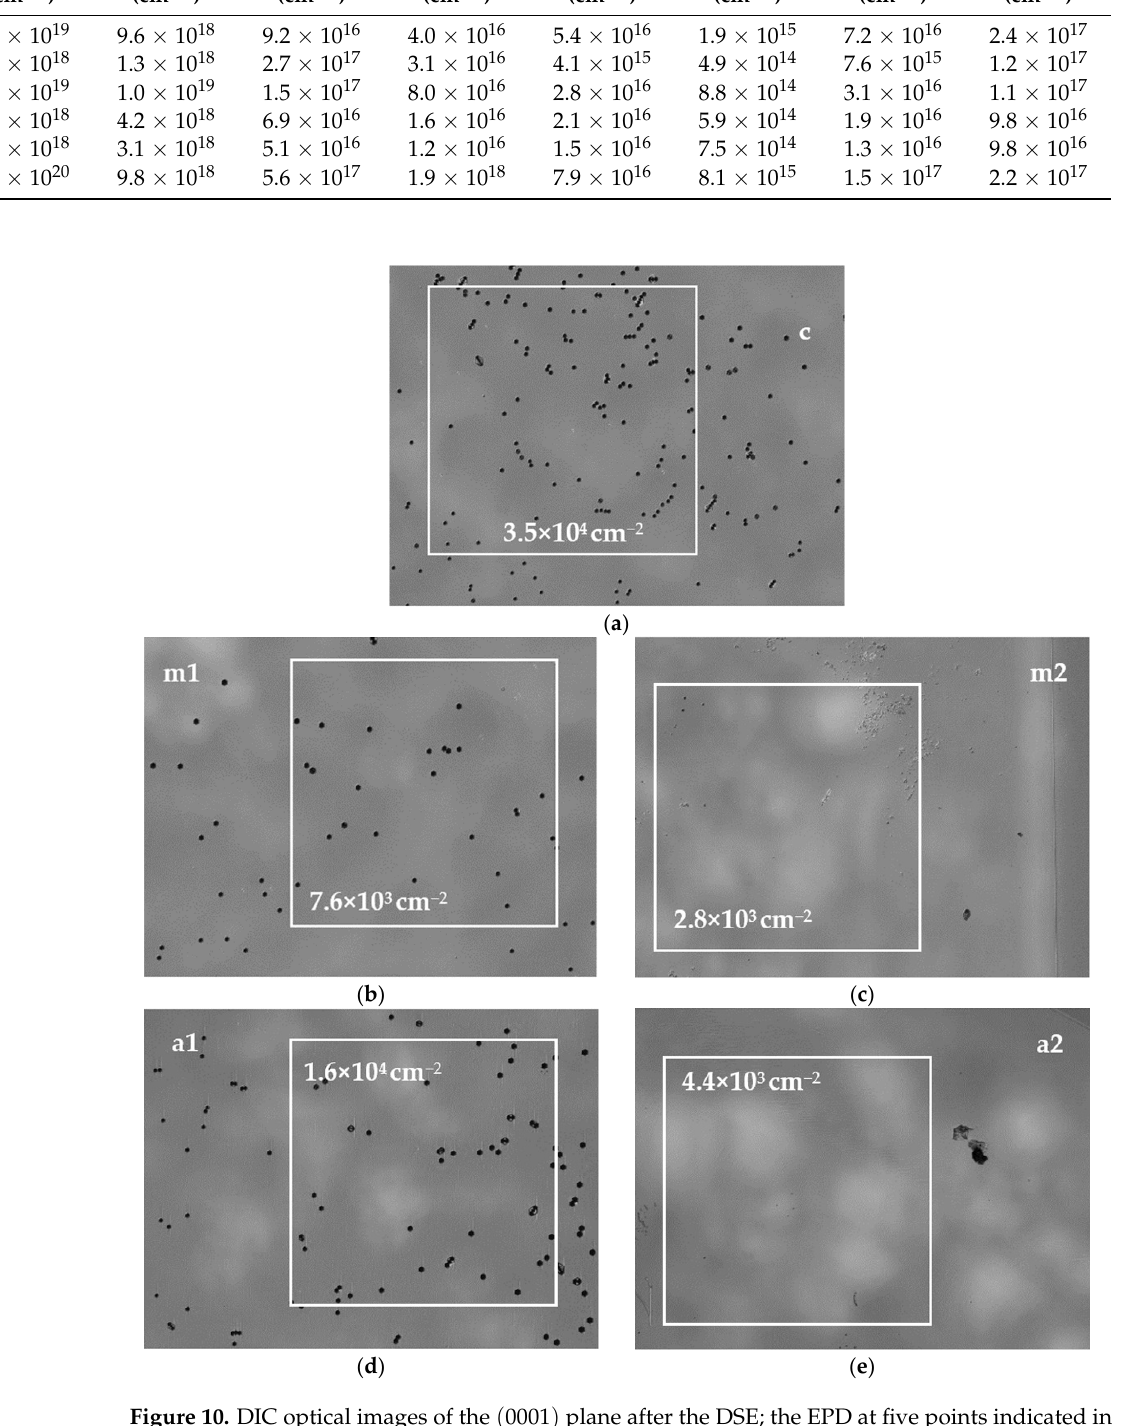
Figure 10. DIC optical images of the (0001) plane after the DSE; the EPD at five points indicated in Figure 2b: ( a ) c, ( b ) m1, ( c ) m2, ( d ) a1 and ( e ) a2; white squares indicate areas of the EPD estimation.